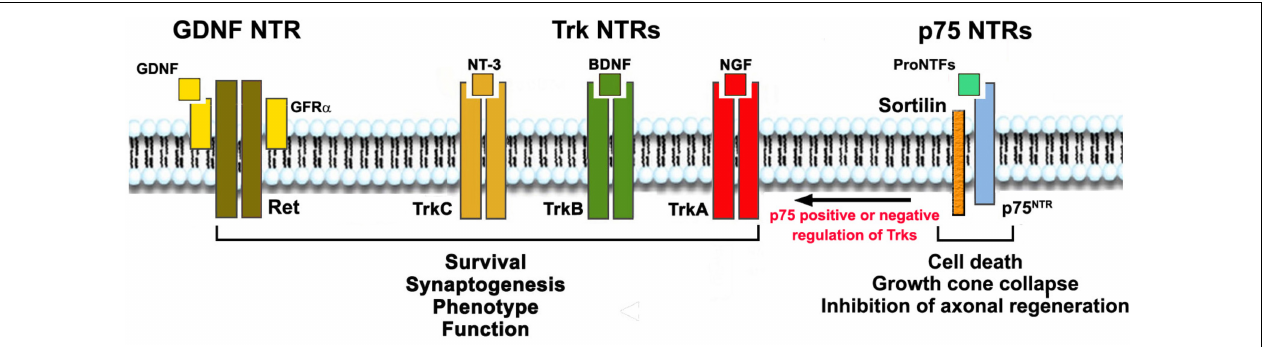
FIGURE 1 | Neurotrophic Factors, their receptors (NTRs) and functions. NTs activate signaling receptors TrkA, TrkB, TrkC, and p75 NTR . Each NT receptor (NTR) can act alone, and all Trks can also cooperate positively or negatively with p75 NTR . GDNF acts through RET but binds the glycosyl-phosphatidylinositol-anchored co-receptor (GFR α 1–4) subunits. Mature NTs (NGF, BDNF, NT-3) bind, respectively, TrkA, TrkB and TrkC with some selectivity. All NTs and the precursor pro-neurotrophin proteins bind to p75 NTR . Growth factor activation of Trks or RET promote survival, growth, differentiation and synaptogenesis. Trk receptors may be present in truncated forms that are not protective (not shown). Growth factor activation of p75 NTR /sortilin complex in neurons leads to apoptosis, growth cone collapse, and inhibition of axonal regeneration; and in glia, activation of p75 NTR leads to production of pro-inflammatory and neurotoxic factors. p75 NTR can